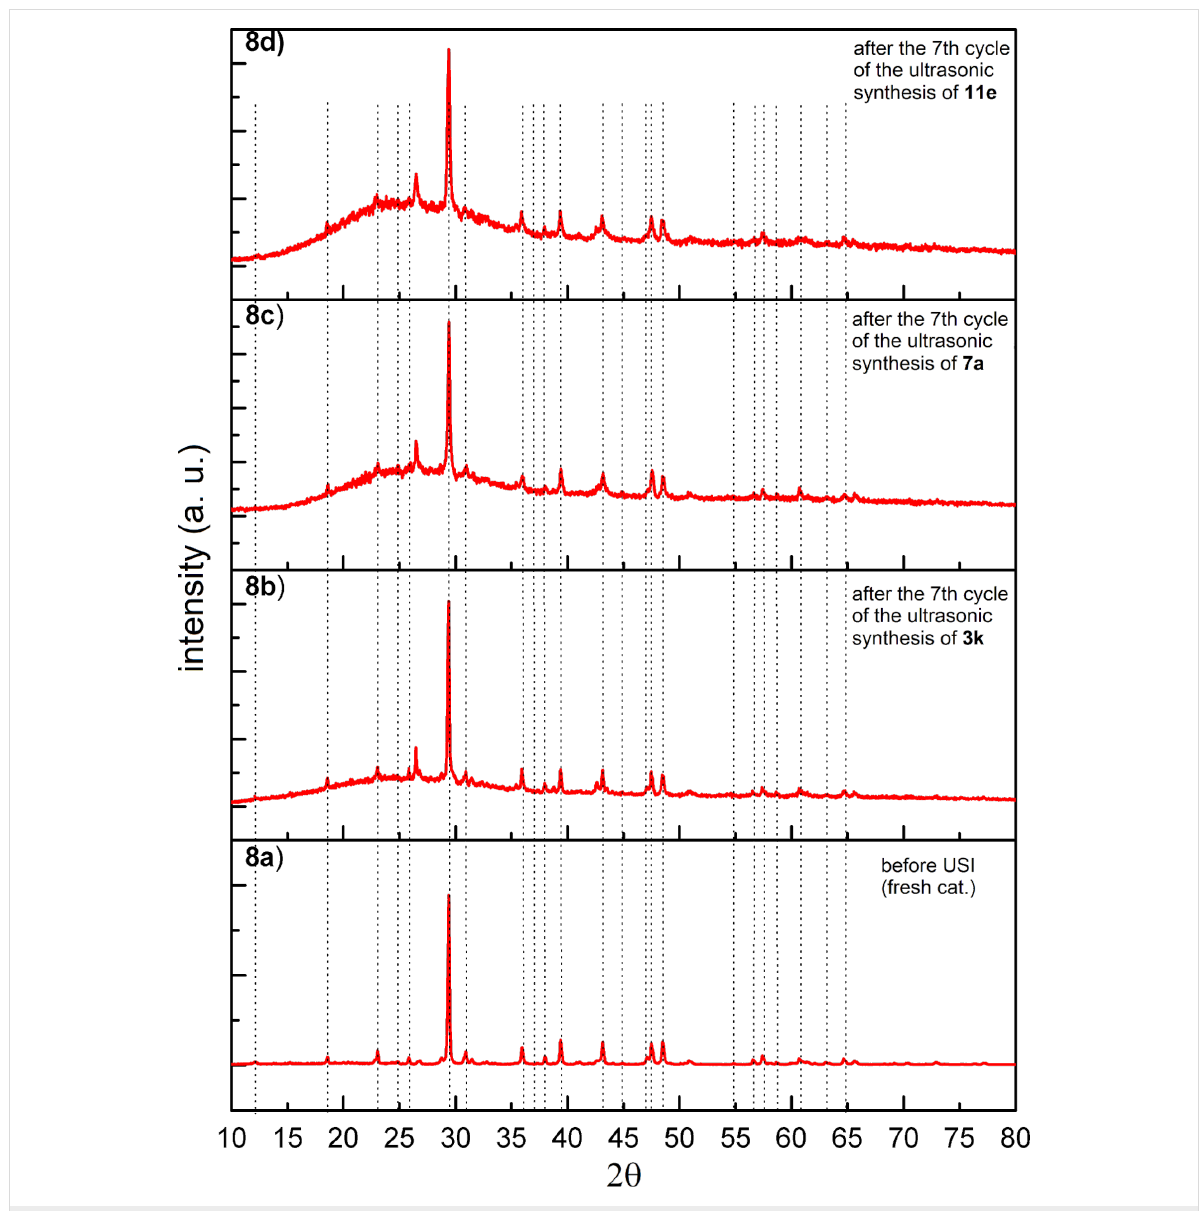
Figure 8: XRD pattern of a) the fresh NDL catalyst; b) the recovered NDL catalyst after the 7th cycle of the ultrasonic synthesis of 3k ; c) the recov- ered NDL catalyst after the 7th cycle of the ultrasonic synthesis of 7a ; and d) the recovered NDL catalyst after the 7th cycle of the ultrasonic synthe- sis of 11e